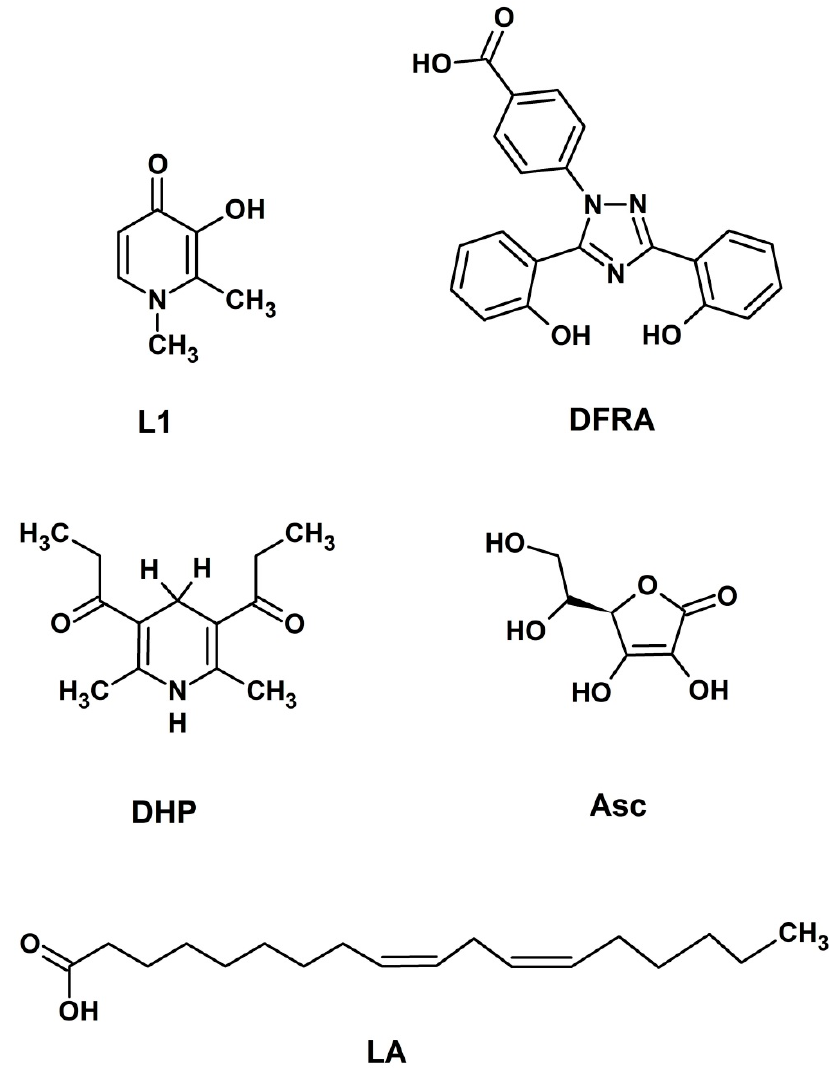
Figure 1. Chemical structures of 3-hydroxy-1,2-dimethylpyridin-4(1 H )-one (deferiprone or L1), 4-[(3 Z ,5 E )-3,5-bis(6-oxo-1-cyclohexa-2,-dienylidene)-1,2,4-triazolidin-1-yl]-benzoic acid (deferasirox or DFRA) (2R)-2-[(1S)-1,2-dihydroxyethyl]-3,4-dihydroxy-2H-furan5-one (ascorbic acid or Asc), (9 Z ,12 Z )-octadeca-9,12-dienoic acid (linoleic acid or LA) and 1,1 ′ -(2,6-dimethyl-1,4-dihydropyridine-3,5-diyl)-di(propan-1-one) (dihydropyridine or DHP).